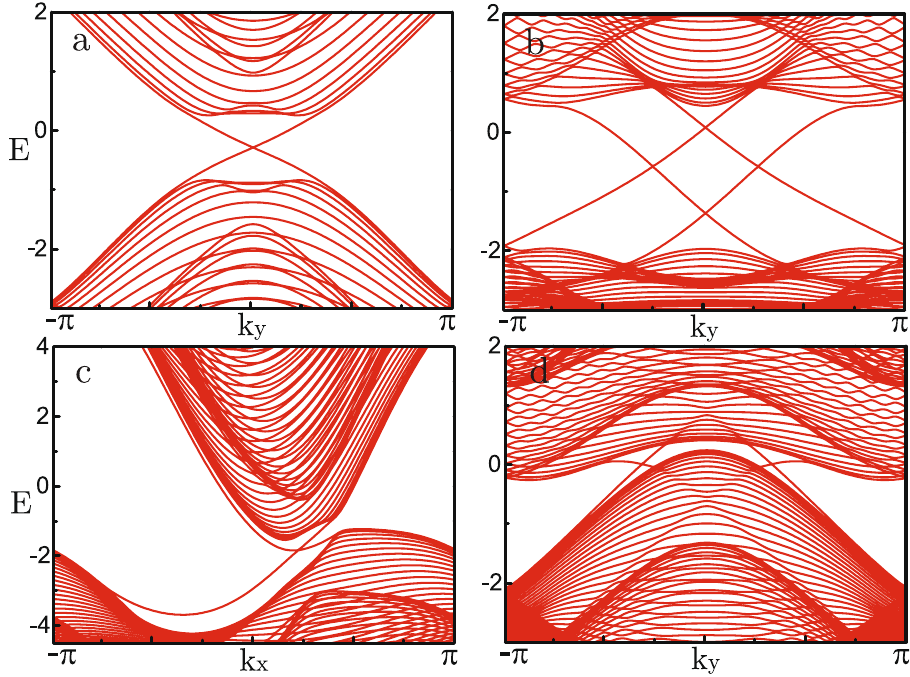
Figure 5. Energy bands for 1D ribbons in the topological nontrivial phases. All figures are parameterized with ε λ = = . = . = . = . t t d 1, 0 6, 0 6, 2 0, 0 8 . Detuning δ = . 3 5, 0 for one pair ( a , c ) and two pair ( b , d ) of edge a b states, whereas magnetic flux 2 /3, /2 φ π π = for topological insulators ( a , b ) and semimetals ( c , d